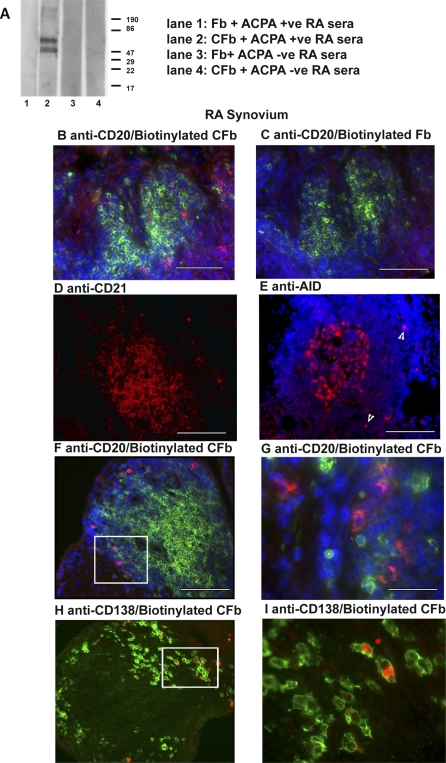
AID+ Aggregates Are Surrounded by Plasma Cells Producing ACPA within Rheumatoid Synovium(A) Immunoblot analysis of reactivity of pooled ACPA+ and RA− sera to citrullinated fibrinogen (CFb) (lanes 2 and 4) and control non-citrullinated fibrinogen (Fb) (lanes 1 and 3). Two protein bands between 60–80 kDa in size, corresponding to the α- and β-chains of CFb, are recognized by the ACPA+ RA sera (lane 2) but not control Fb (lanes 1). ACPA− sera (lanes 3 and 4) show no immunoreactivity toward either citrullinated or control Fb.(B–I) Double or single immunofluorescence analysis showing phenotypic characterization and immunoreactivity towards citrullinated proteins within RA synovial tissue. Sequential sections of RA synovial tissue were double stained with anti-CD20 to detect B-cells (green) together with either biotinylated CFb (B, red) or control biotinylated Fb (C). Sections were counterstained with DAPI. Positive staining is only seen in the sections incubated with biotinylated CFb, confirming the presence of anti-citrullinated protein immunoreactivity.(D–I) Sequential sections of rheumatoid synovium stained with anti-CD21 to detect FDC (D), anti-AID (E), double stained with anti-CD20 (green) and biotinylated CFb (red) (F, G) and double stained with anti-CD138 (green) to detect plasma cells and biotinylated CFb (red) (H, I). CD21 was visualized with vector red. AID, CD20, CD138, and biotinylated CFb were incubated with secondary Abs/streptavidin conjugated to ALEXA fluorochromes. AID and CD20 were counterstained with DAPI. ACPA Ab-producing cells were seen scattered around FDC and AID+ aggregates (F). ACPA+ cells were consistently CD20− (G) (60× magnification of F) and CD138+ (H) (60× magnification of G). Original magnification was 20× (B–F, H). Scale bars: 200 μm (D–F, H), 50 μm (B, C) 20 μm (G, I).